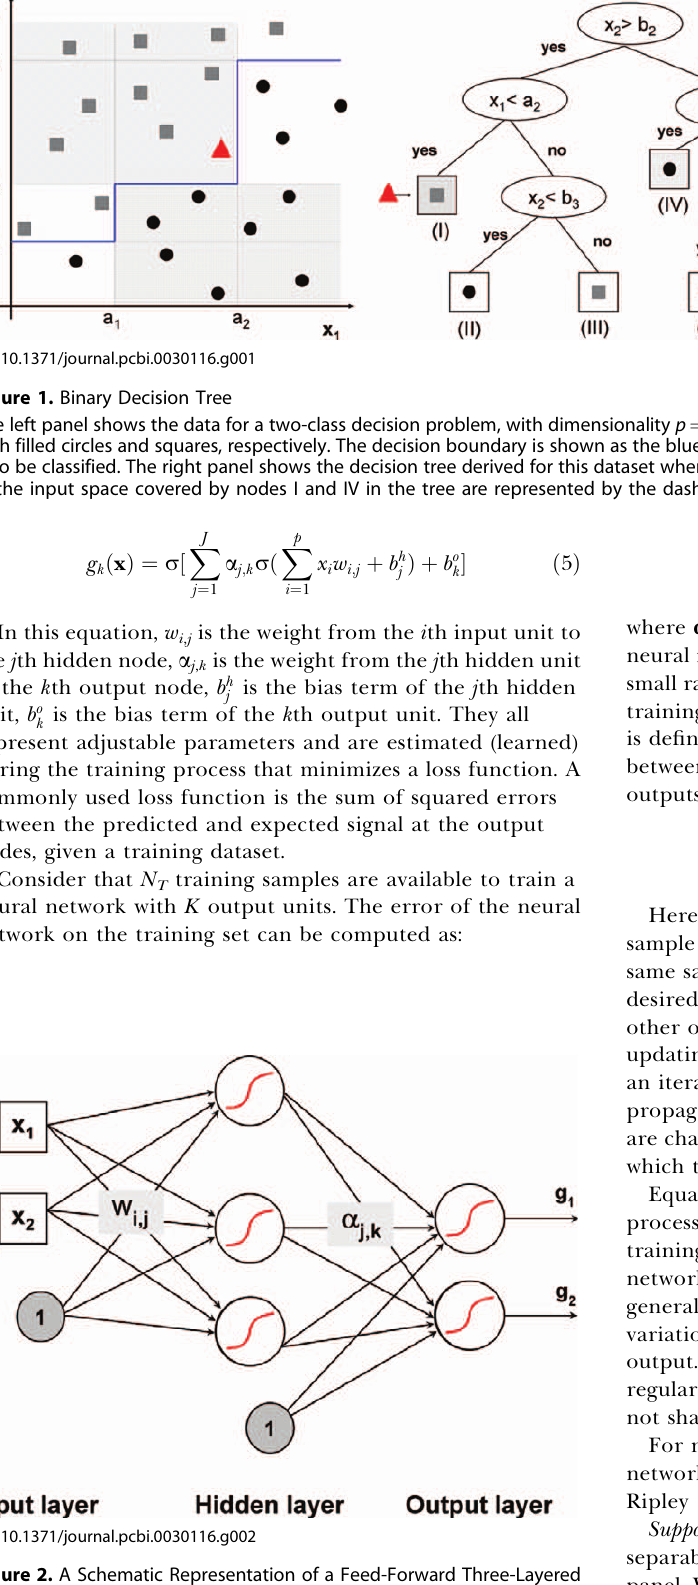
Figure 2. A Schematic Representation of a Feed-Forward Three-Layered Neural Network Two-dimensional data points ( p ¼ 2) are classified into K ¼ 2 known classes. The sigmoid hidden and output units are shown as white circles containing an S-like red curve.